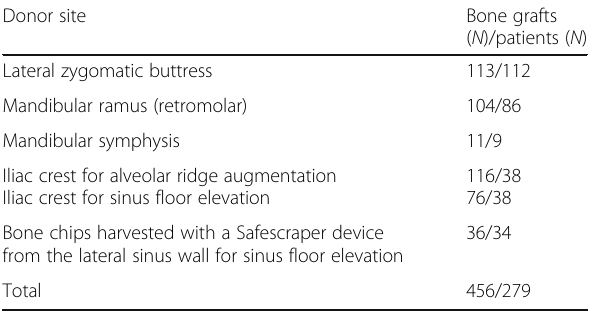
Table 2 Donor sites and numbers of bone grafts as well as distribution in patients in this study